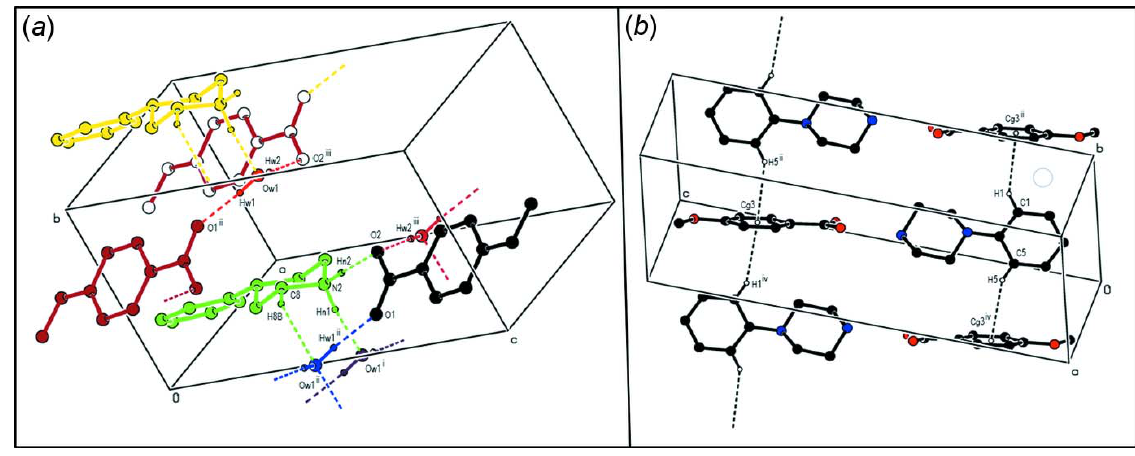
hydrogen bonds (Table 4, Fig. 8 a ) and C—H (cid:2) (cid:2) (cid:2) (cid:2) interactions, generating sheets parallel to the (100) plane (Table 4, Fig. 8).